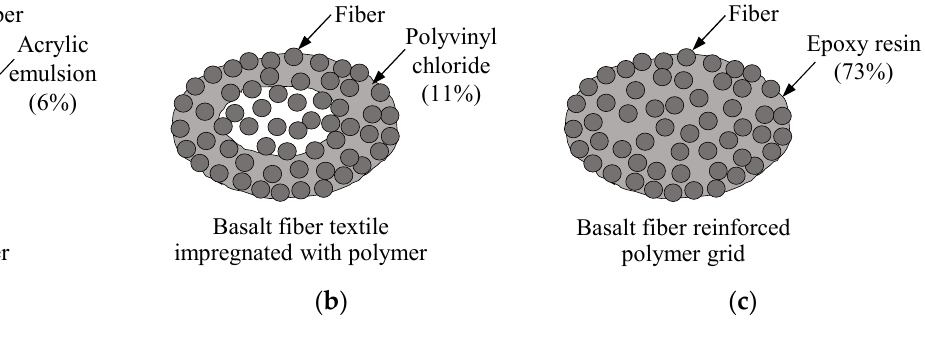
Figure 2. Schematic diagram of the grid cross-section: ( a ) T5; ( b ) T25; ( c ) G50.